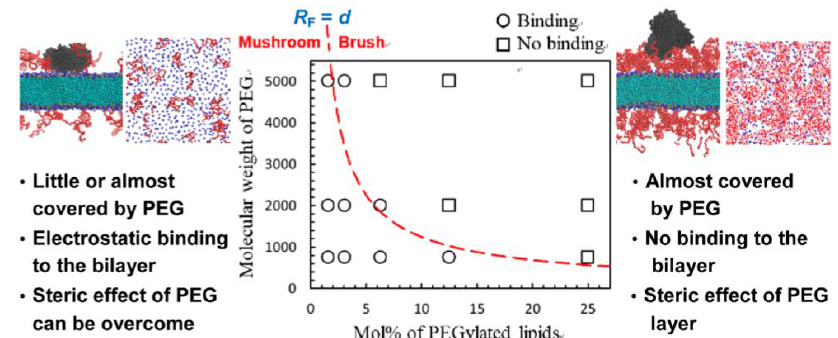
Figure 4. The adsorption of human serum albumin (HSA; black color) onto the PEGylated membrane surface (PEG in red), depending on mushroom and extended-brush conformations of PEG chains with different sizes and grafting densities. Reproduced with permission from [39], American Chemical Society, 2016.